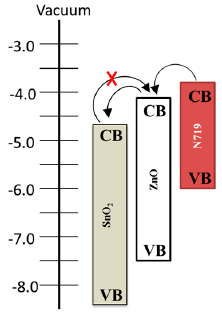
Figure 6. Schematic diagram of electron transfer mechanism for the SnO 2 /ZnO nanocomposite photoanode.